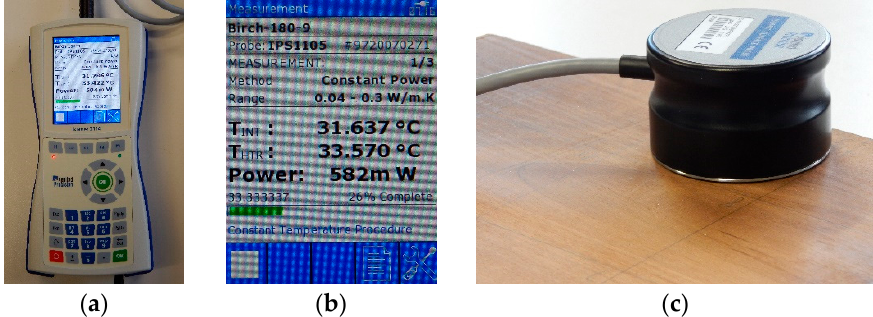
Figure 4. Photos from the measurement of thermal characteristics; ( a ) instrument ISOMET 2114 during measurement, ( b ) display of the instrument, ( c ) surface probe of the instrument and test sample.